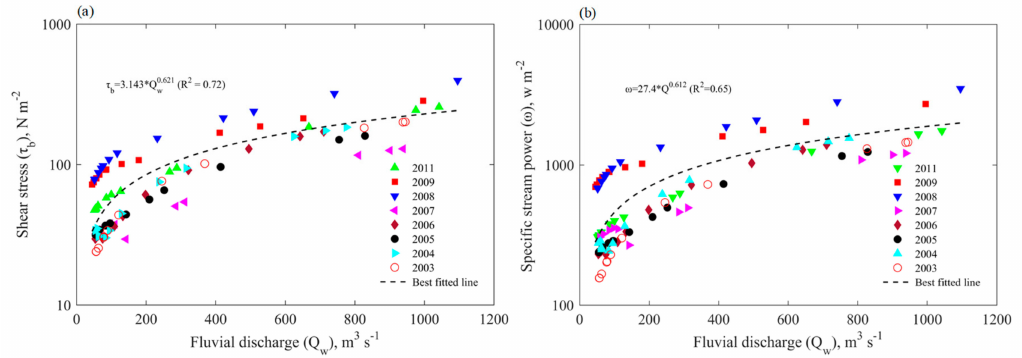
Figure 3. Relationship of fluvial discharge and ( a ) shear stress and ( b ) specific